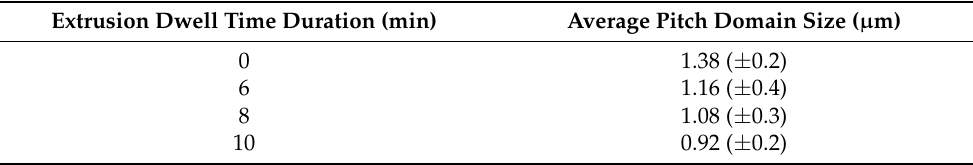
Table 3. Particle size and air gap with extrusion dwell time.